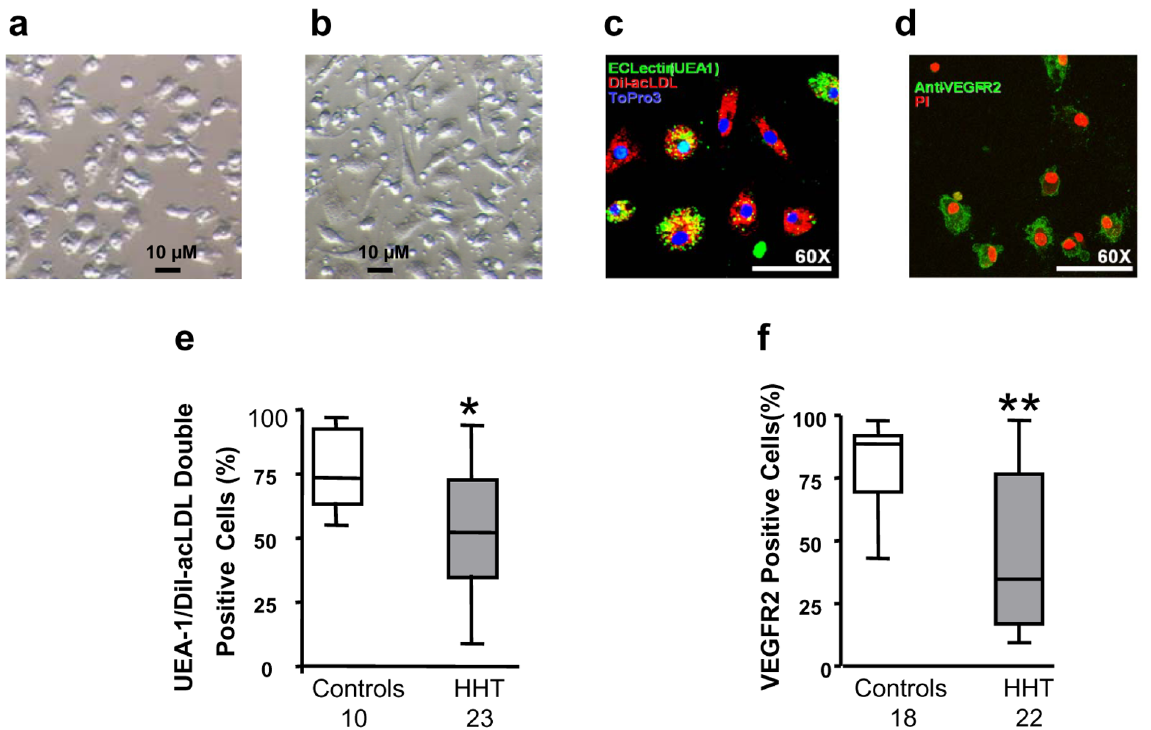
Figure 2. Reduced development of endothelial cellular phenotypes in CACs from HHT patients. CACs derived from patients with HHT appeared smaller in size and more rounded (a) when compared to the spindle-shaped, elongated morphology of CACs derived from control subjects (b). Dil-Ac-LDL/UEA-1 double positive cells (a representative image shown in c. Orange: double positive; green: UEA-1 positive; red: Dil-Ac-LDL positive; blue is nuclear stain) and VEGFR2 positive cells (a representative image shown in d. Green: VEGFR2 positive; red is nuclear stain) in CACs were analyzed by immunofluorescence microscopy. The results showed that percentage of Dil-Ac-LDL/UEA-1 double positive cells and percentage of VEGFR2 positive cells, both were significantly lower in CACs isolated from HHT patients (e and f). * p , 0.05, compared with healthy controls. ** p , 0.01, compared with healthy controls.